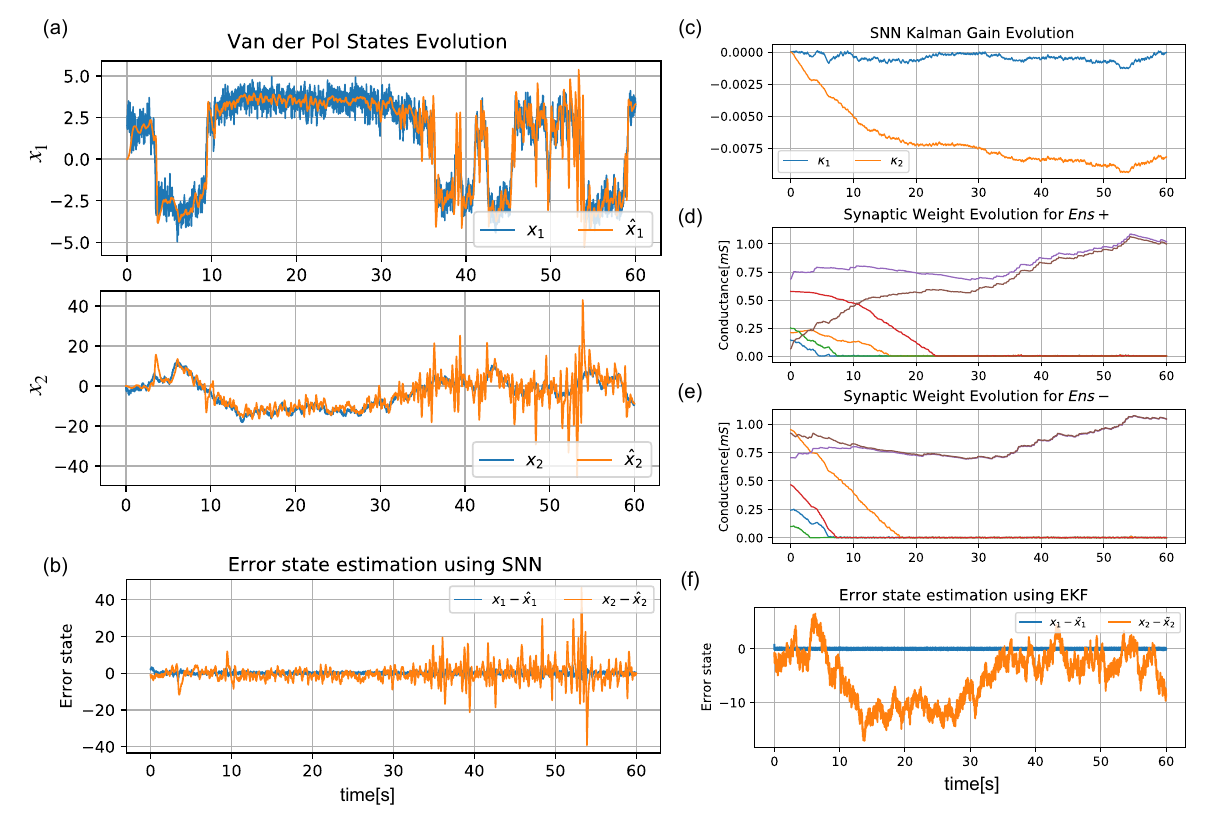
Figure 6. Time evolution of the reconstruction of the Van der Pol oscillator using the proposed architecture in comparison with the ground truth. ( a ) Comparison of the ground truth x (blue) with the of the reconstruction ˆ x (orange) made using the proposed architecture. ( b ) Time error reconstruction x − ˆ x of the two states of the system. ( c ) Time evolution of each value of the resulting Kalman gain matrix. ( d , e ) Weight value evolution over time of the 3 × 2 synapse set (multiple colors) for Ens + and Ens − , respectively. ( f ) Time error state estimation of the Van der Pol system using the standard discrete EKF algorithm without knowledge of the covariance matrices Q , R